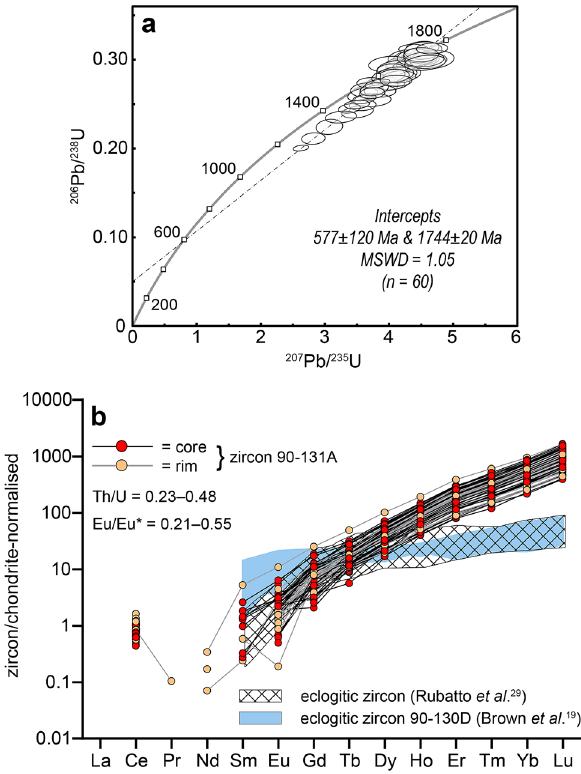
Figure 4. ( a ) Wetherill concordia plot showing U–Pb zircon analyses (all data, n = 60). 2σ uncertainties are at 95% confidence. ( b ) Chondrite-normalised rare earth element (REE) plot for 60 analyses of zircon. Normalisation values from Sun and McDonough 36 . Representative eclogitic zircon REE pattern is from eclogitic micaschist MST2a 34 (Sesia–Lanzo Zone), and patterns obtained from zircons in eclogite sample 90-130D shown in blue 20